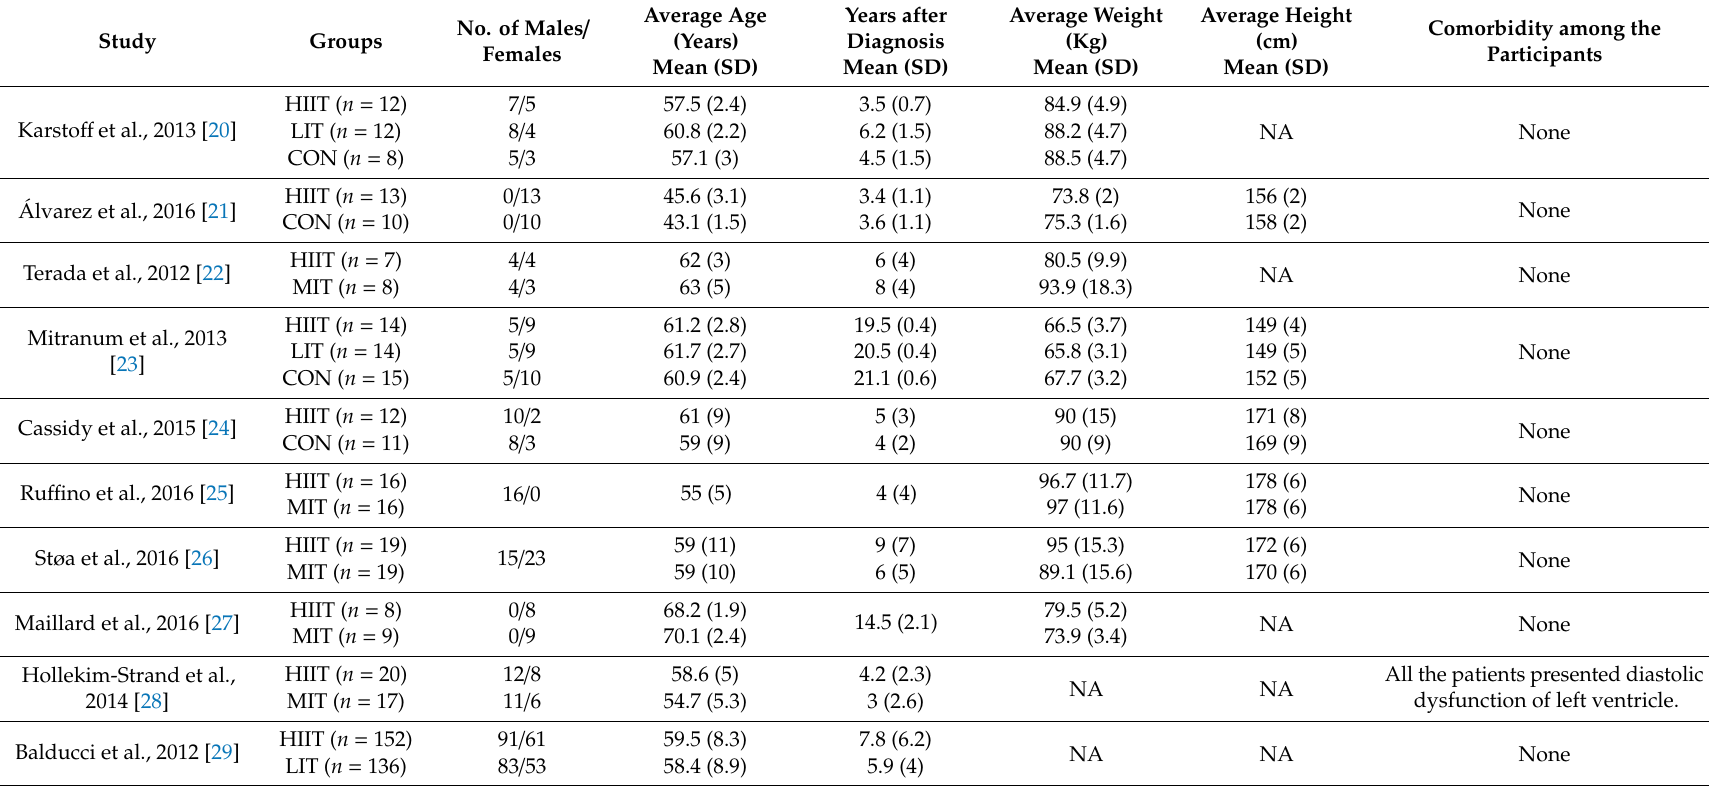
Table 2. Main characteristics of participants in the